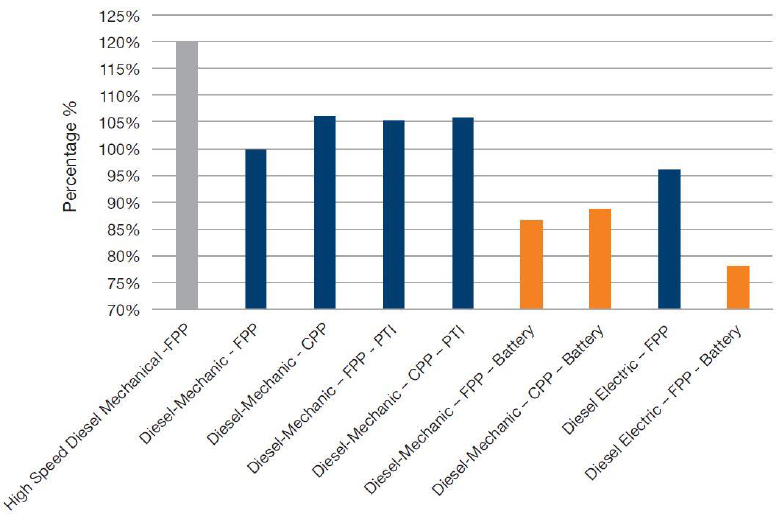
Figure 12. Fuel consumption comparison of different tug propulsion systems [70].